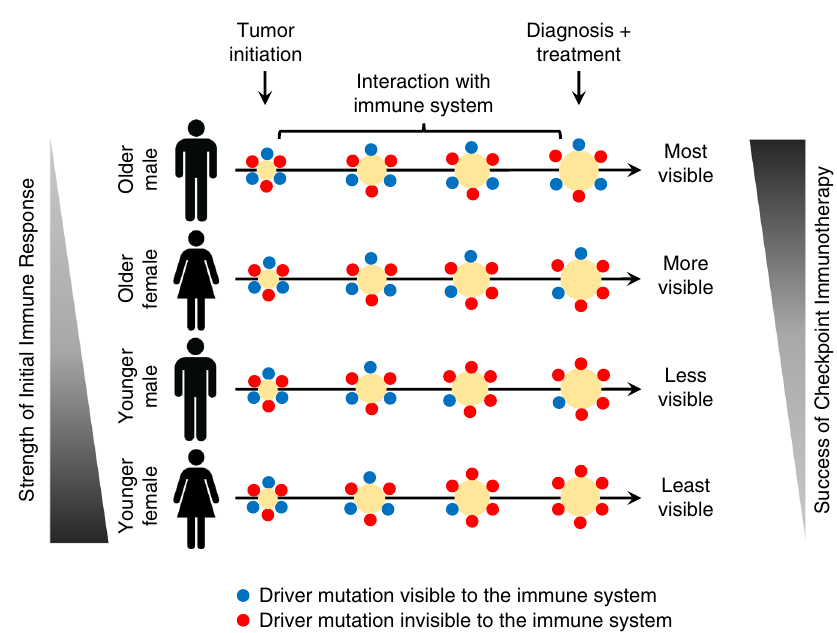
Fig. 5 Proposed model of the relationship between immune selection and immunotherapy in cancer patients. Young females experience the strongest immune response, rendering their diagnosed tumors more invisible to the immune system and dif fi cult to treat with ICB. On the other extreme, old males experience the weakest immune response, leaving their diagnosed tumors more visible to the immune system and open to attack when stimulated with ICB. Blue dots indicate immunologically visible driver mutations while red dots indicate immunologically invisible driver mutations at various time